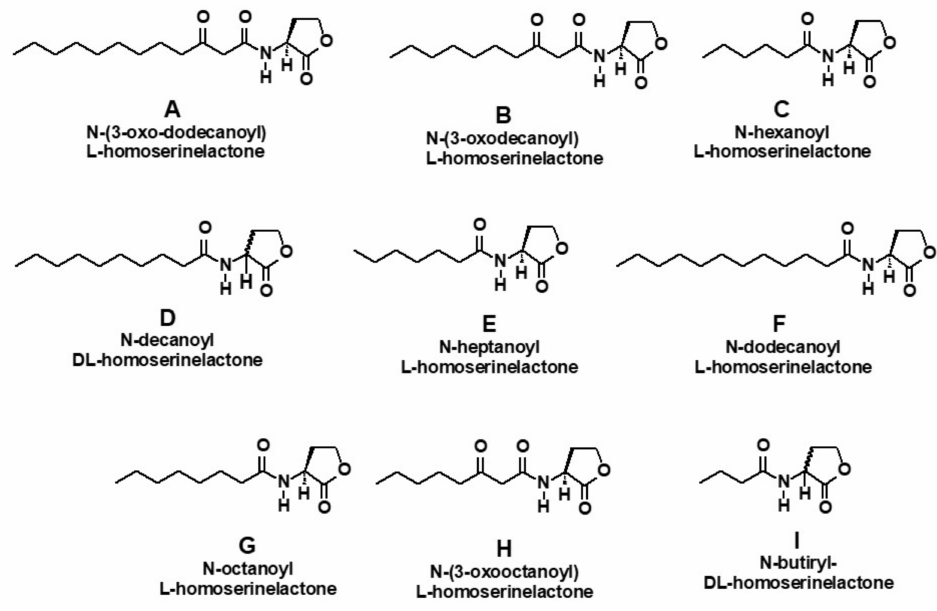
Figure 1. Structure of homoserine lactones assayed against M. aeruginosa and C. raciborskii .